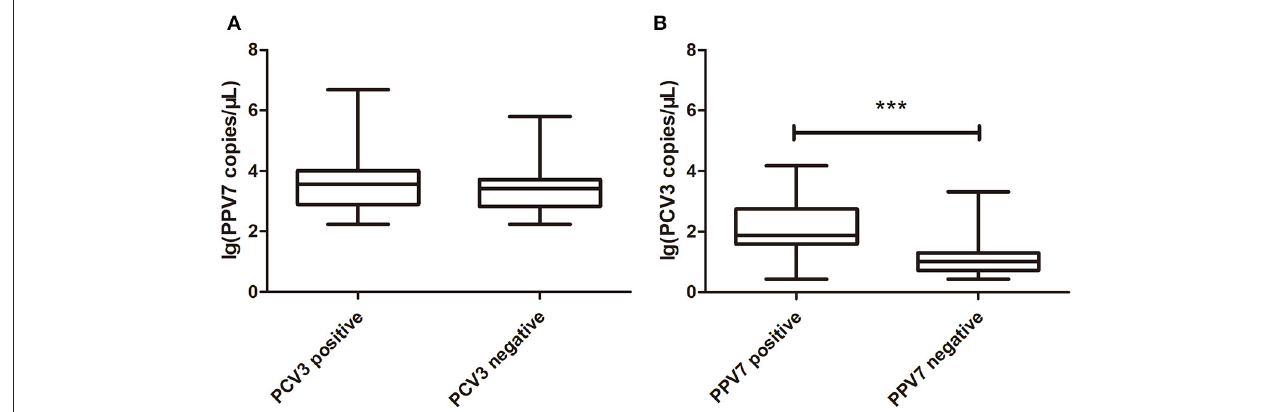
FIGURE 1 | Boxplot comparison of real-time PCR copy number of PPV7 and PCV3. (A) Boxplot comparison of real-time PCR copy number of PPV7 in PCV3 positive ( n = 28) and PCV3 negative ( n = 19) serum samples. (B) Boxplot comparison of real-time PCR copy number of PCV3 in PPV7 positive ( n = 28) and PPV7 negative ( n = 27) serum samples. *** p < 0.001.